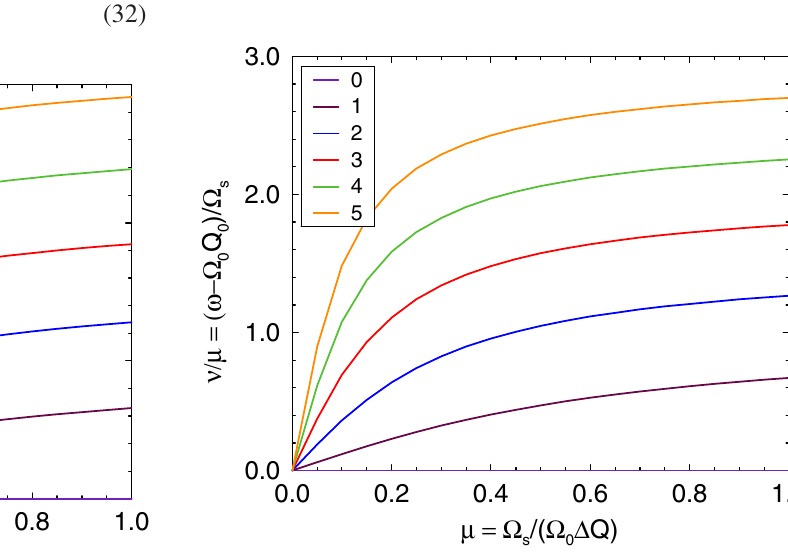
FIG. 3. (Color) Normalized eigenvalues of the parabolic bunch.